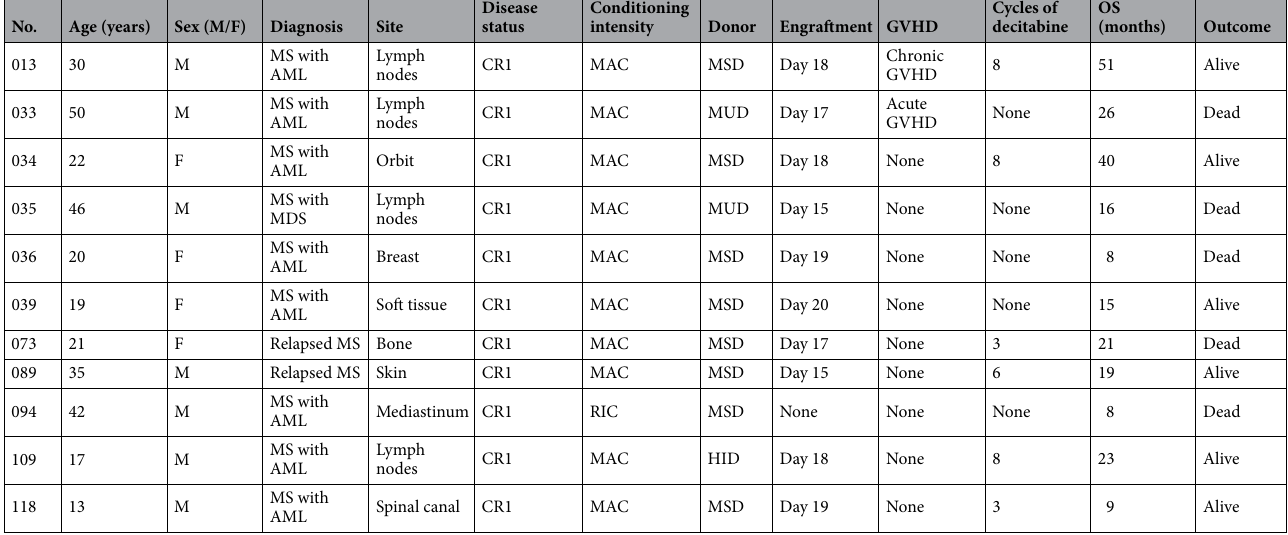
Table 4. Characteristics of 11 MS patients who received HSCT. MS myeloid sarcoma, AML acute myeloid leukemia, MDS myelodysplastic syndrome, HSCT hematopoietic stem cell transplantation, GVHD